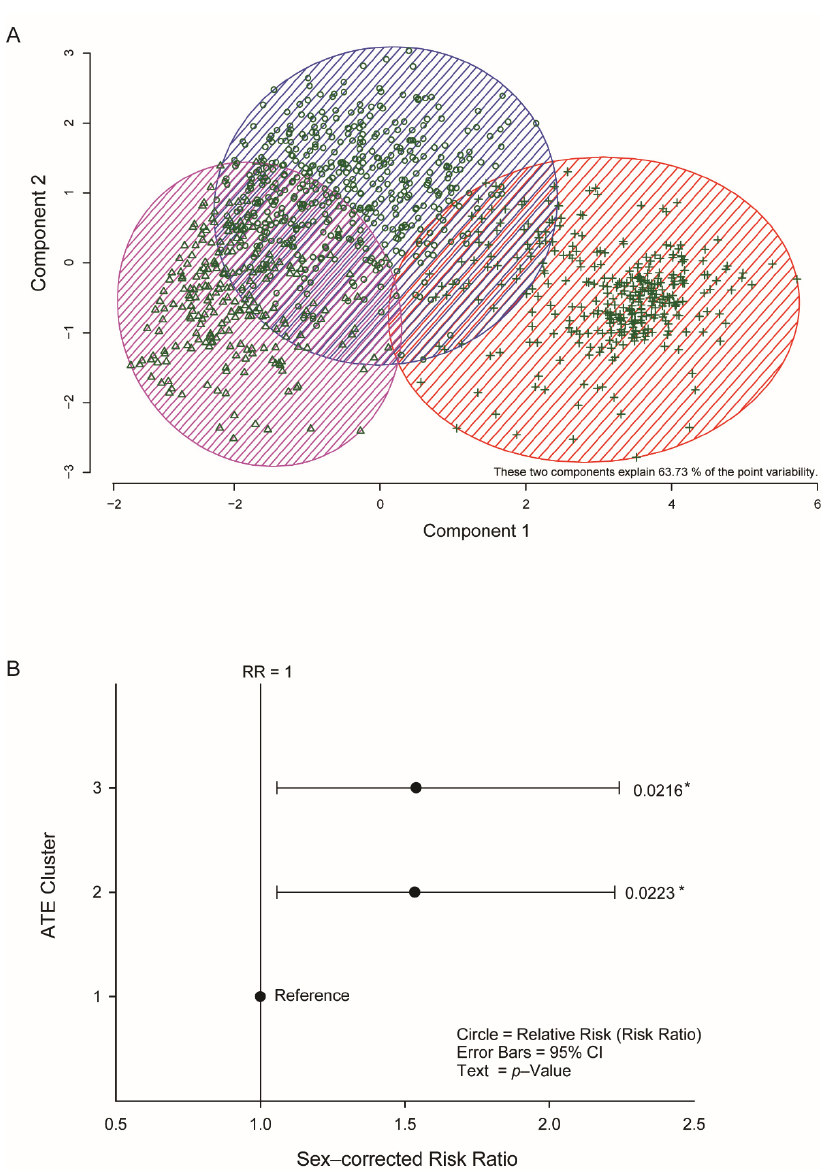
Figure 3. Exposure to adult traumatic events (ATE) is linked to IgA seropositivity in asymptomatic or oligosymptomatic individuals. ( A ) The two principal components after K-means clustering of the responses to the ATE questionnaire identified three clusters of responses. Circles (blue shaded area)—Cluster 1; Triangles (pink shaded area)—Cluster 2; Crosses (red shaded area)—Cluster 3. ( B ) Sex-adjusted relative risk CTQ subscales identified ATE clusters 2 and 3 (negative and positive salience, respectively) as having a similar effect on SARS-CoV-2 IgA seropositivity. Circles represent the relative risk (RR); error bars: 95% confidence interval; text: p -value. *, p <